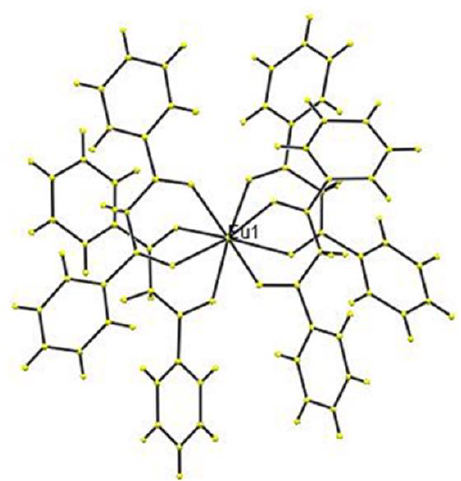
Figure 1. Structure of the europium tetrakis (dibenzoyl methide) triethylammonium (EuD 4 TEA) complex.